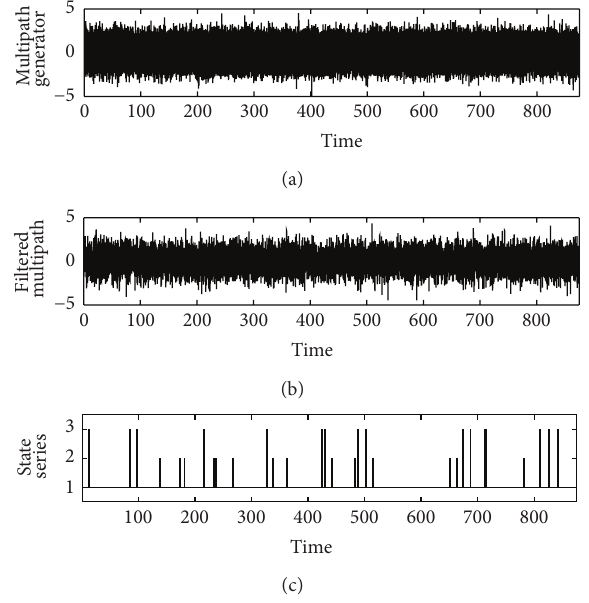
Figure 5: Multipath generated signal and state series: (a) generated samples, (b) filtered signal, and (c) state series.